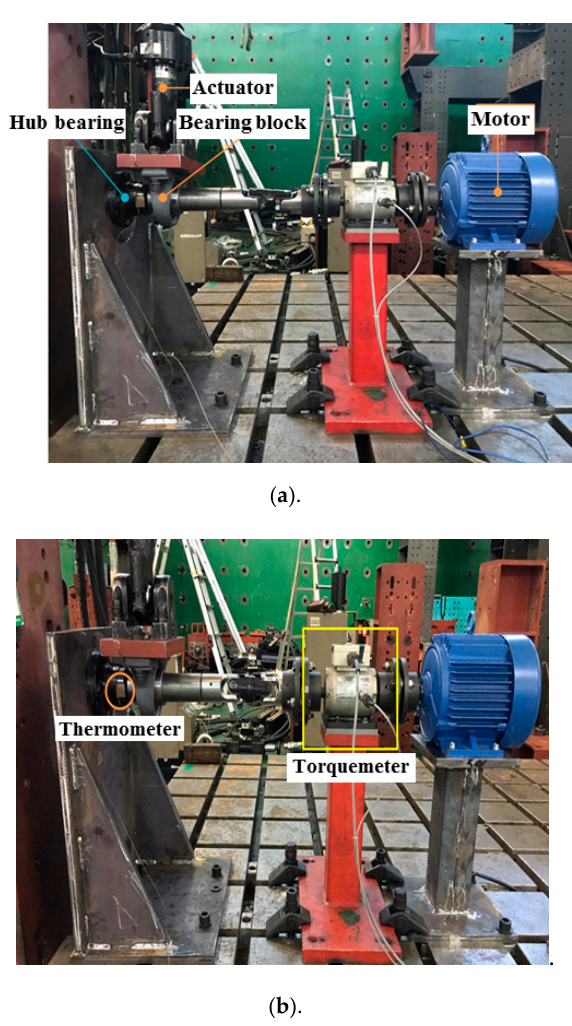
Figure 17. Test rig for hub bearing. ( a ) Test rig ( b ) Locations of measuring sensors. Table 3. Specifications of components for test rig.